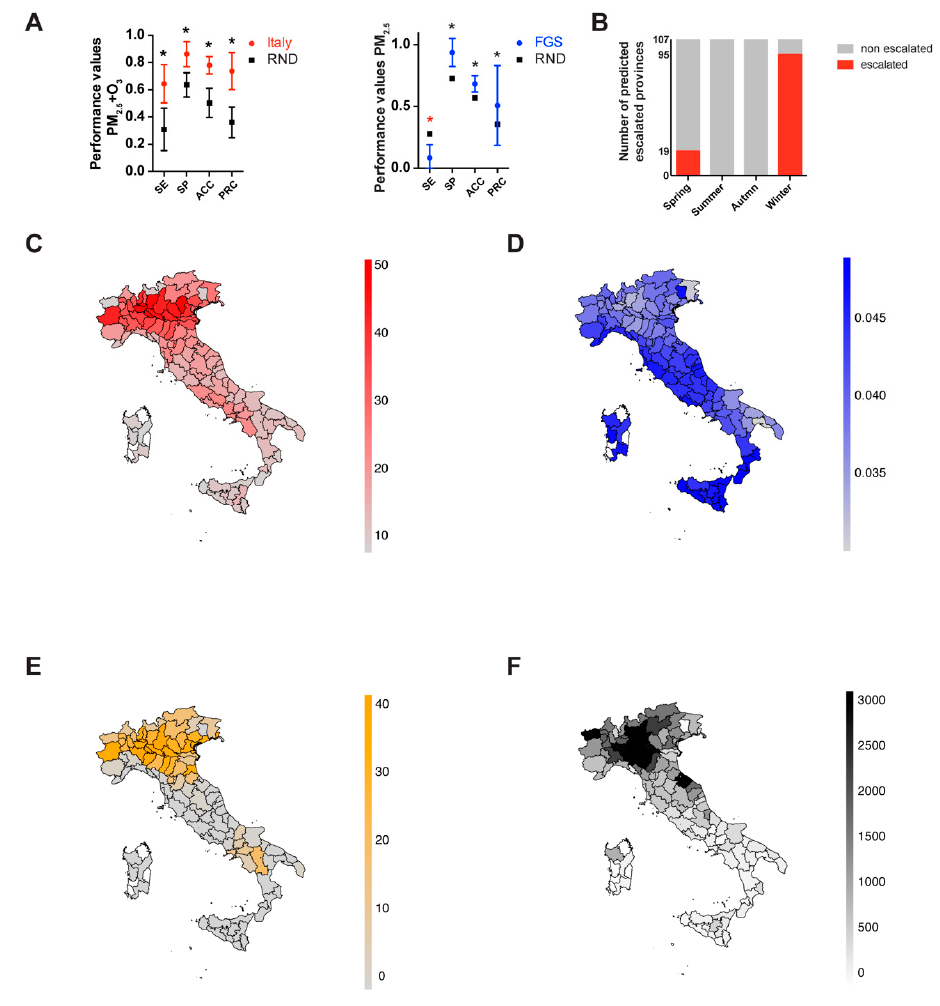
Figure 3. ANN performance assessment. ( A ) Performance values of the ANN on the 107 Italian provinces (left) and FGS (right) data. SE sensitivity, SP specificity, ACC accuracy, PRC precision. The dots represent the ANN average performance based on 100 Monte Carlo cross-validations. Bars represent the standard deviation. Red dots Italian provinces, blue dots FGS regions and black dots random dataset. ( B ) The histogram represents the number of the escalated Italian provinces (107) considering the PM 2.5 and O 3 concentrations in four months, March, June, September, and December, representative of the four seasons: Spring, Summer, Autumn, and Winter. Red bars, number of escalated provinces, grey bars, remaining non escalated provinces. Statistical analysis were performed using multiple t test corrected with the Sidak–Boneferroni method for multiple comparisons ( p < 0.001). Black asterisk indicates that the classifier performs better than the null classifier. Red asterisk indicates that the classifier performs worse than the null classifier. ( C – F ) The spatial administrative maps representing PM 2.5 ( µ g / m 3 , red), O 3 (ppm, blue), prediction (number of positive predictions, orange) and actual reported cases (number of cases per million, black) for the Italian provinces. ( E ) The color intensity on the map represents the number of times that provinces in the test dataset were positive for the outbreak in one hundred Monte Carlo cross-validations. ( F ) The number of actual reported cases was limited to 3000 per million to increase the dynamic range of the